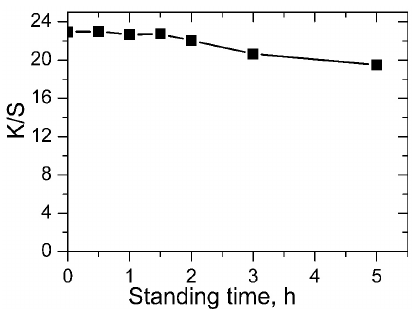
Figure 4. K / S values of the prints when pretreatment bath standing for 0, 0.5, 1, 1.5, 2, 3, and 5 h.